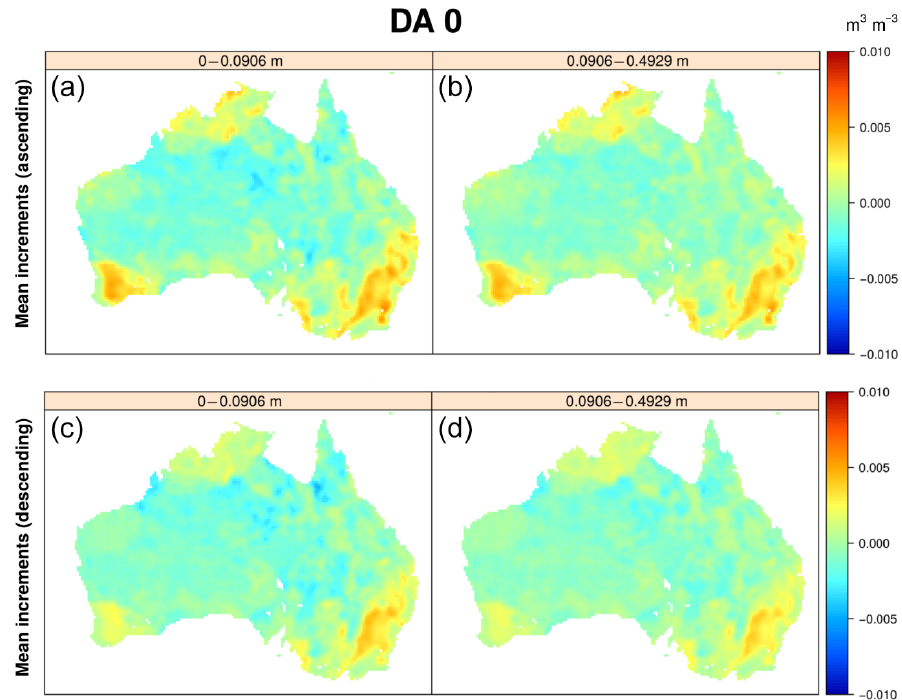
Figure 4. Mean of all increments for experiment DA 0 for top-layer soil moisture (a, c) and root-zone soil moisture (b, d) for ascending (a, b) and descending orbits (c, d) .